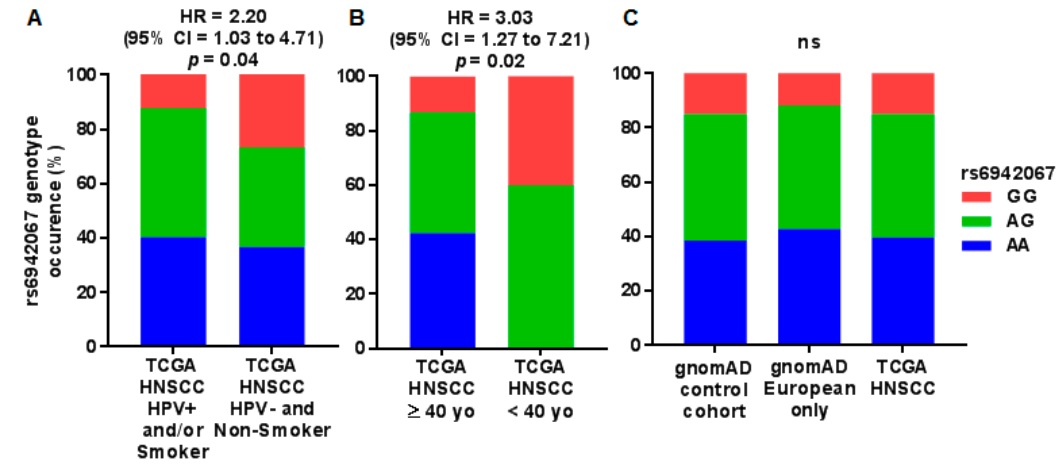
Figure 1. rs6942067 genotype status in the Cancer TCGA HNSCC cohort and the gnomAD cohort. Comparison of rs6942067 genotype for ( A ) HPV positive and/or smoking patients ( n = 124) and non-smoker and HPV negative patients ( n = 30) of the TCGA HNSCC cohort; ( B ) ≥ 40 years old ( n = 144) and <40 years old ( n = 10) patients of the TCGA HNSCC cohort; and ( C ) all participants of the gnomAD cohort ( n = 15,654), European participant of the gnomAD cohort ( n = 9431), and patients of the TCGA HNSCC cohort. Only 154 patients had whole genome sequencing data for the TCGA HNSCC cohort. Relative risk and p values are for a Pearson’s chi-square test and a recessive model of penetrance.